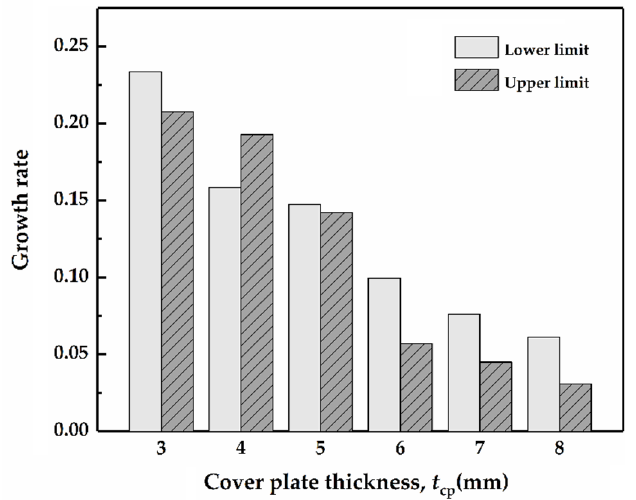
Figure 12. The growth rate of the upper and lower limits of transition impact velocity when the cover plate connection mode changes from free to fixed.